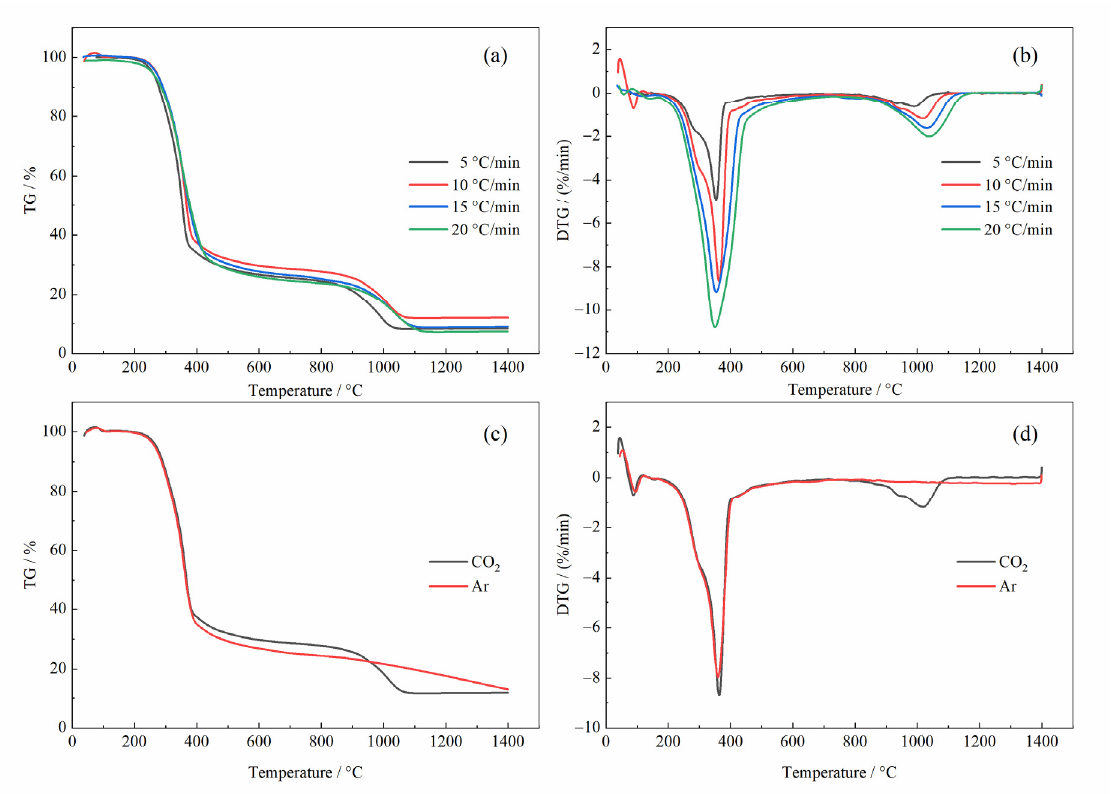
Figure 1. TGA results of pine wood sawdust: ( a ) TG and ( b ) DTG with different heating rates; ( c ) TG and ( d ) DTG under CO 2 and Ar (10 °C/min).